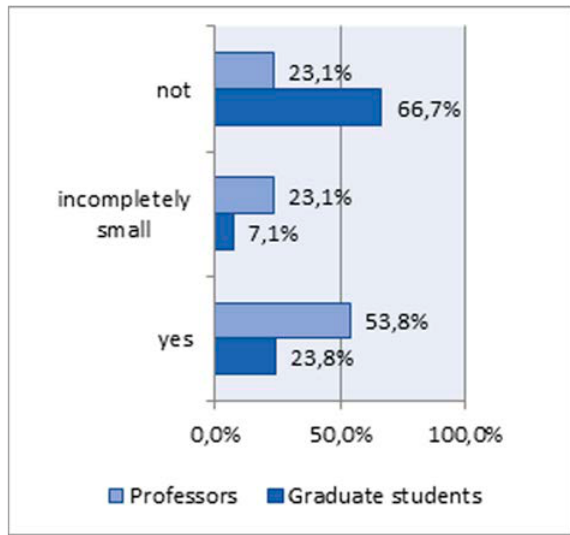
Fig. 4. Respondents' opinions on the adequacy of information on higher education reforms.